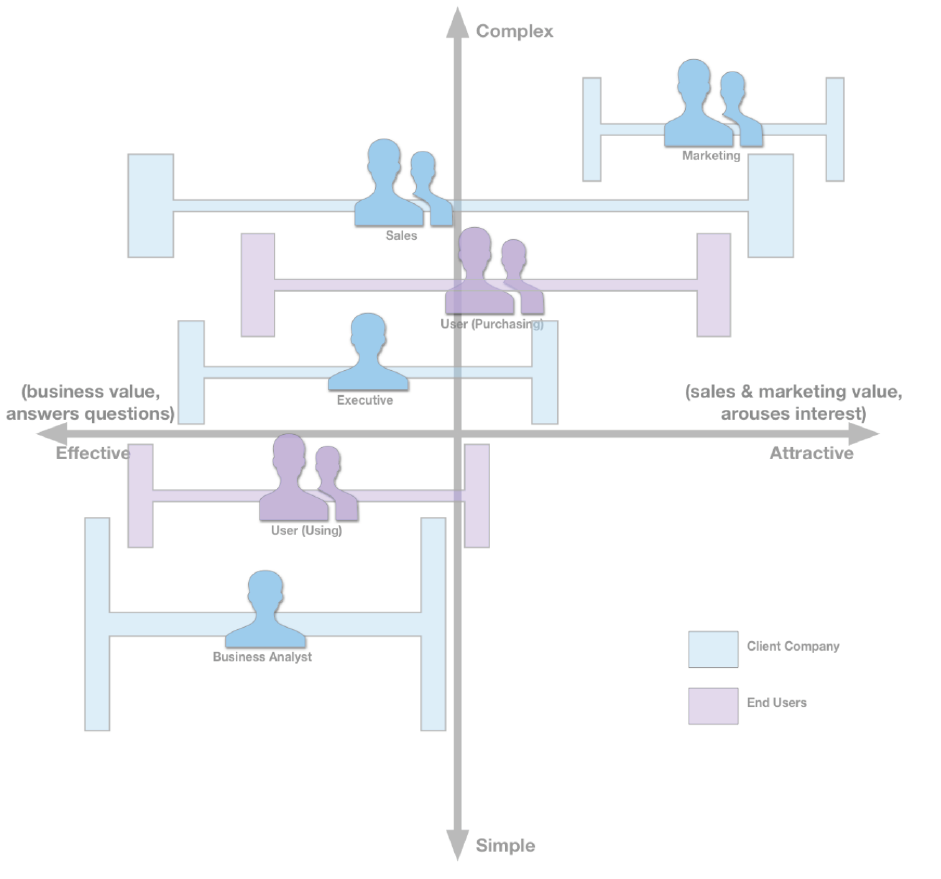
Figure 10. The stakeholder visualisation requirements map. The x-axis ranges from “effective” to “attractive” and the y axis ranges from “simple” to “complex”. The marketing departments expectations of a visualisation rank highly in both complexity and attractiveness, but indicate less interest about its effectiveness. Image courtesy of Keahey